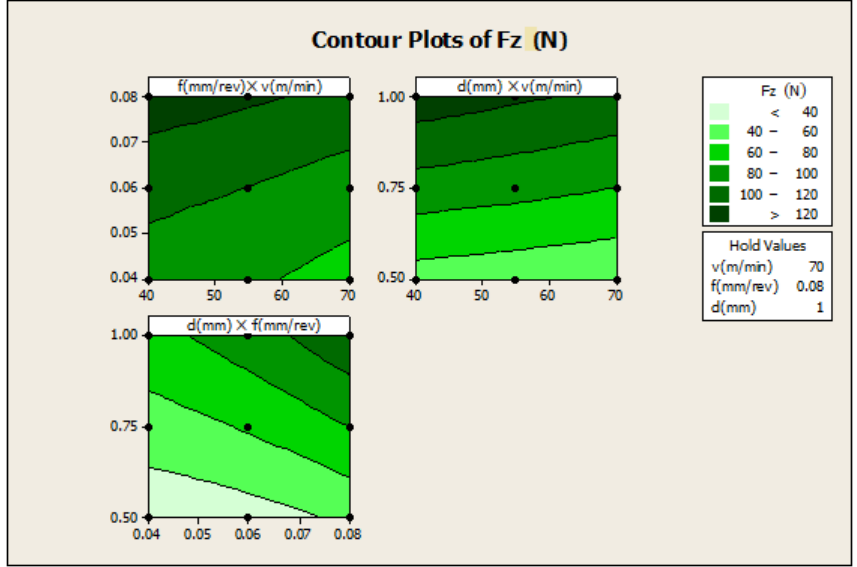
Figure 6. Contour plot for Fz.